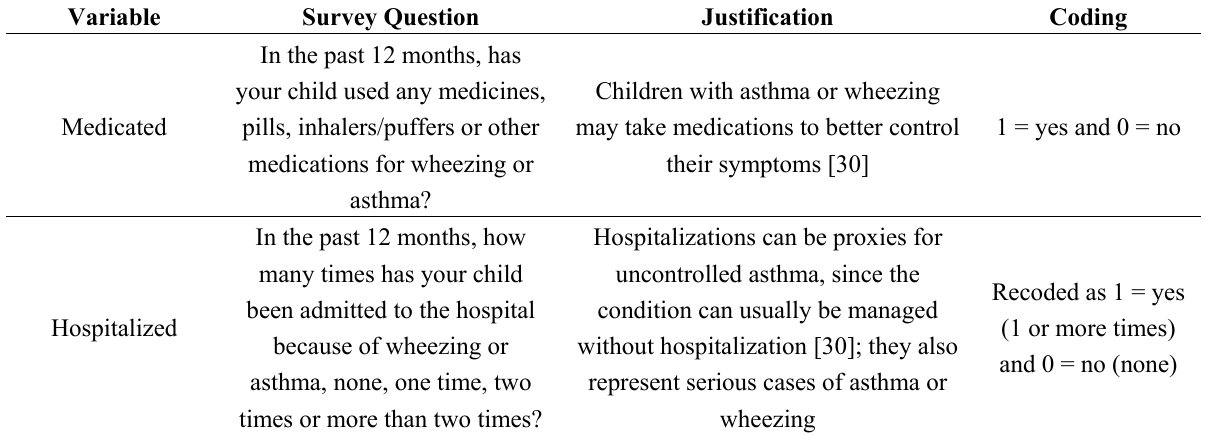
Table 3. Access to care variables: survey questions, justification and